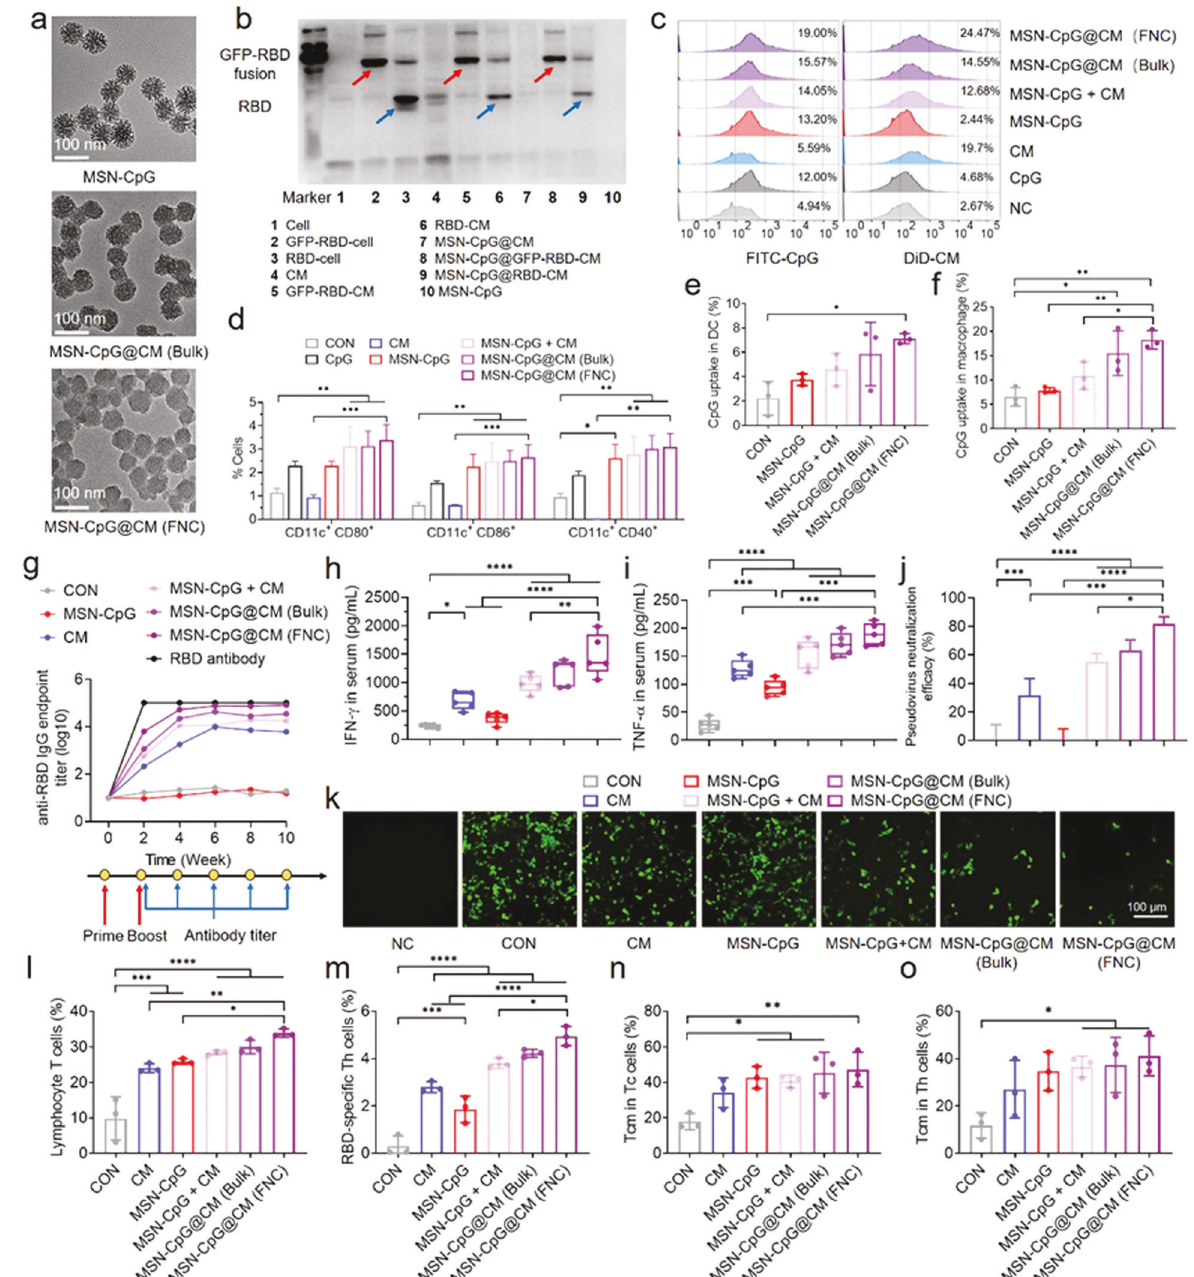
Fig. 1 Scalable engineering of biomimetic SARS-CoV ‑ 2 nanovaccines with robust protective immune responses. a TEM images of biomimetic nanovaccines. b Western blot analysis of RBD and GFP-RBD fusion expression on the cell membrane, cell membrane vesicles and nanovaccines. c Flow cytometry analysis of bone marrow-derived dendritic cells (BMDCs) internalization after 4 h of incubation with DiD- labeled cell membrane coated, FITC-labeled CpG loaded nanoparticles. d Quanti fi cation of DC maturation markers CD40, CD80 and CD86 after 24 h of incubation with nanovaccines through fl ow cytometry analysis. e , f Uptake of FITC-labeled nanovaccines by DCs ( e ) and macrophages ( f ) in the lymph node at 24 h after s. c. injection ( n = 3). All the data were presented as mean ± SEM. g Total RBD-speci fi c IgG